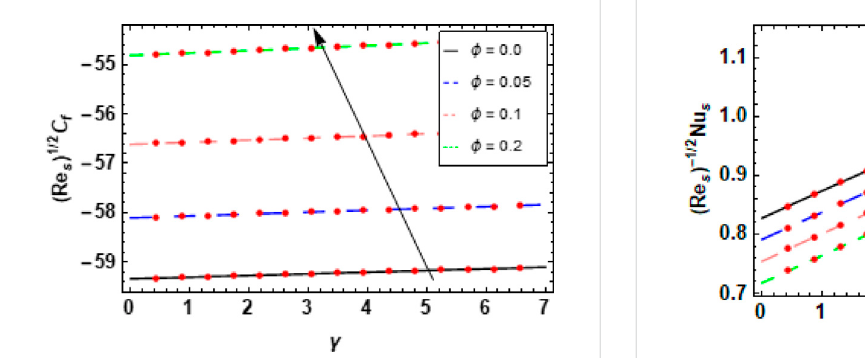
FIGURE 14 In fl uences of γ and ϕ on skin friction.